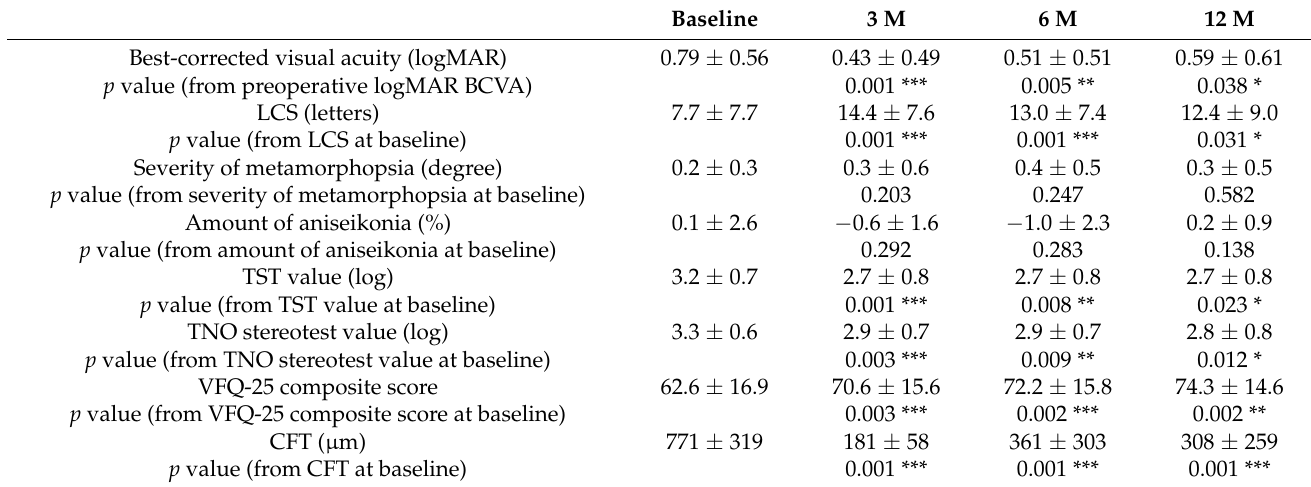
Table 2. Visual functions and CFT at baseline and 3, 6, and 12 months after treatment.